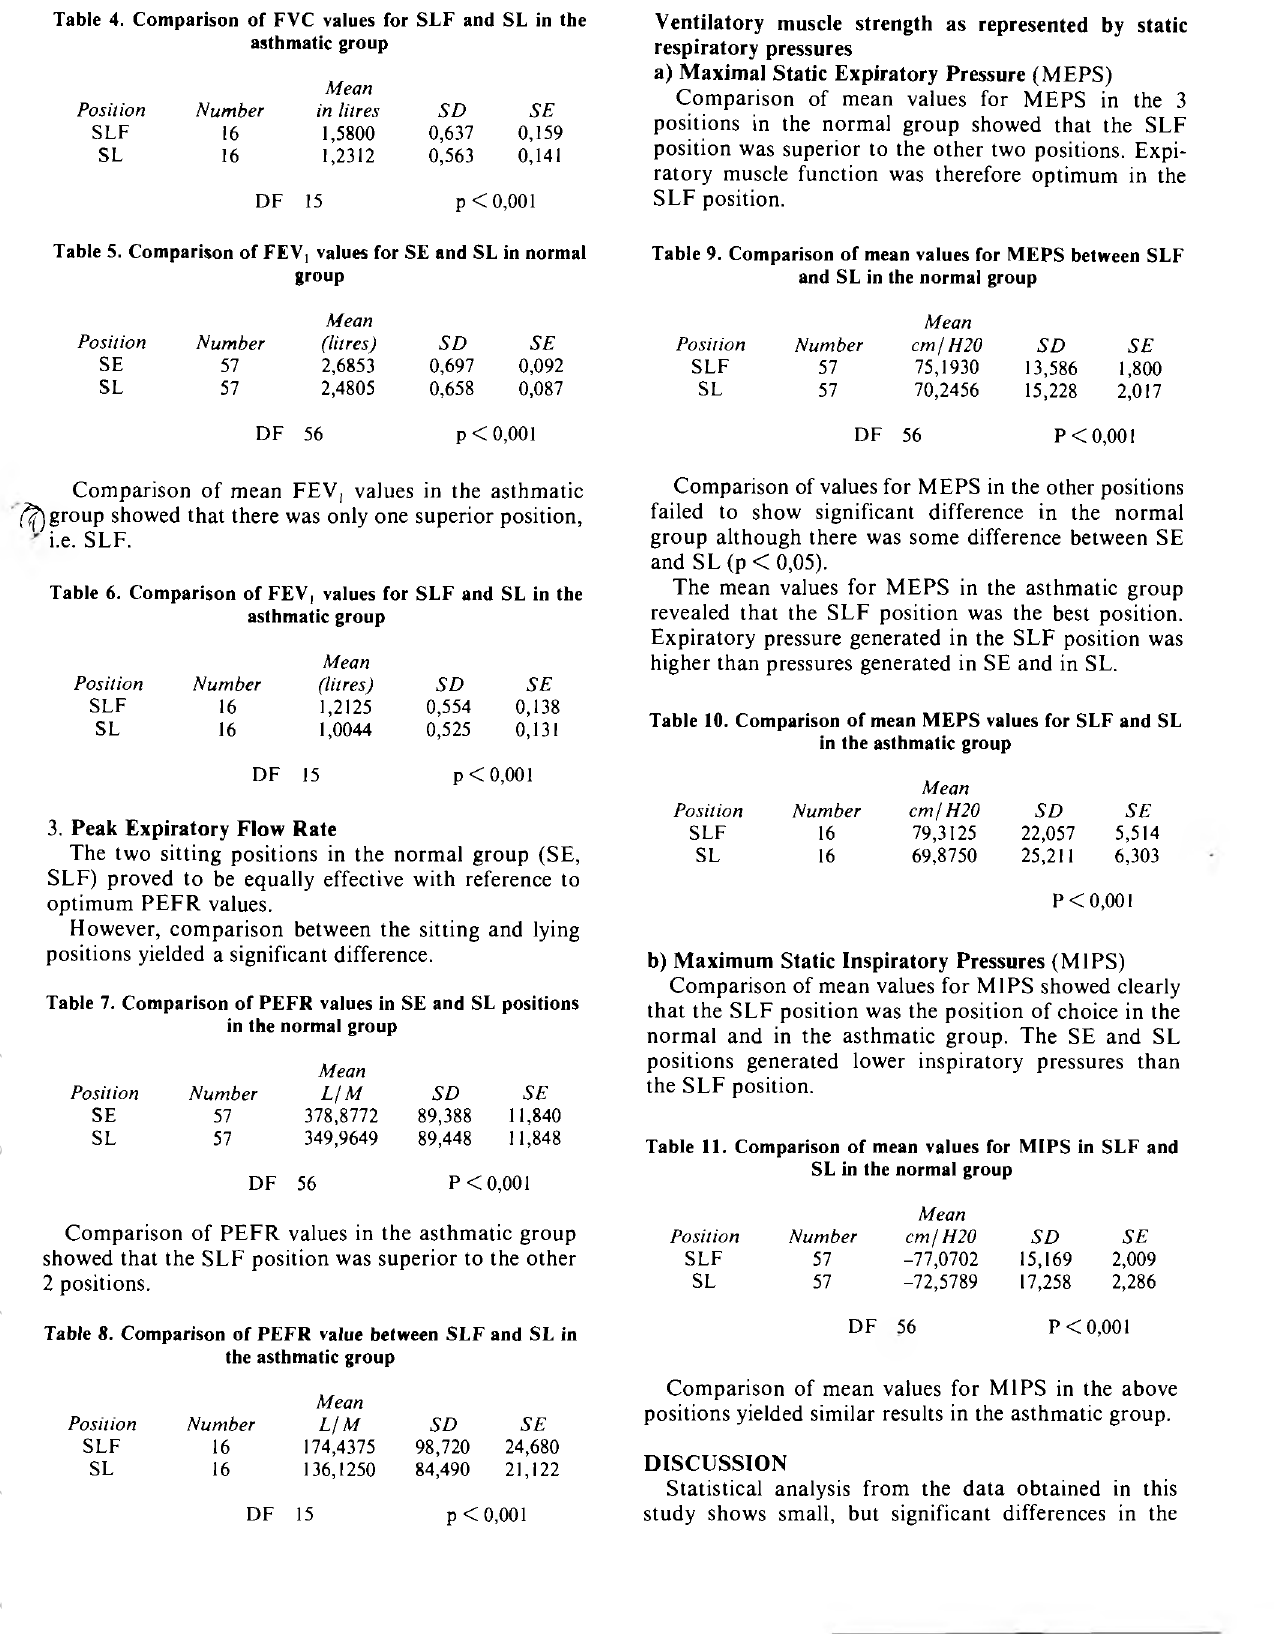
Table 9. Comparison of mean values for M EPS between SLF and SL in the normal group